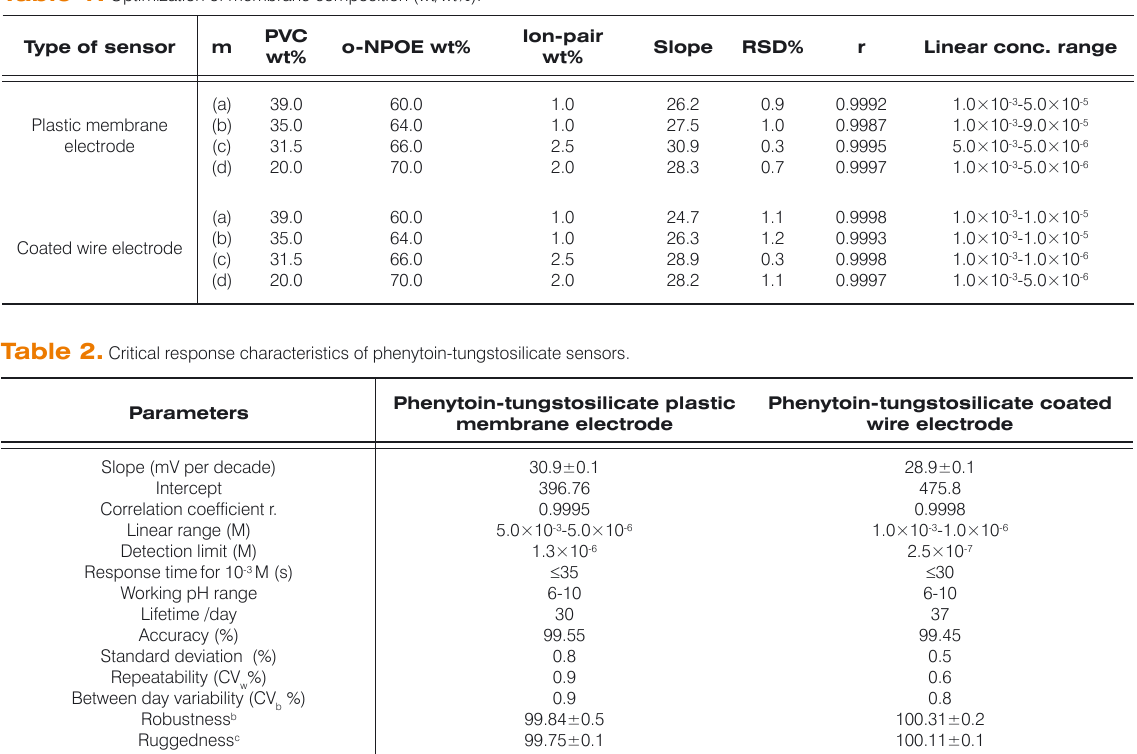
Table 1. Optimization of membrane composition (wt/wt%).